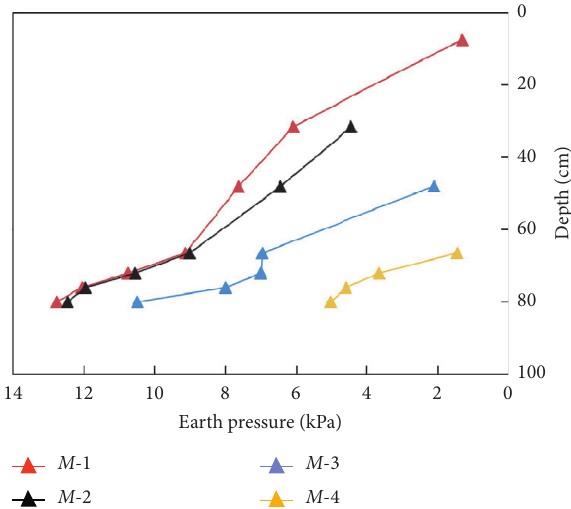
Figure 19: Earth pressure in front of the wall of 0.30H.